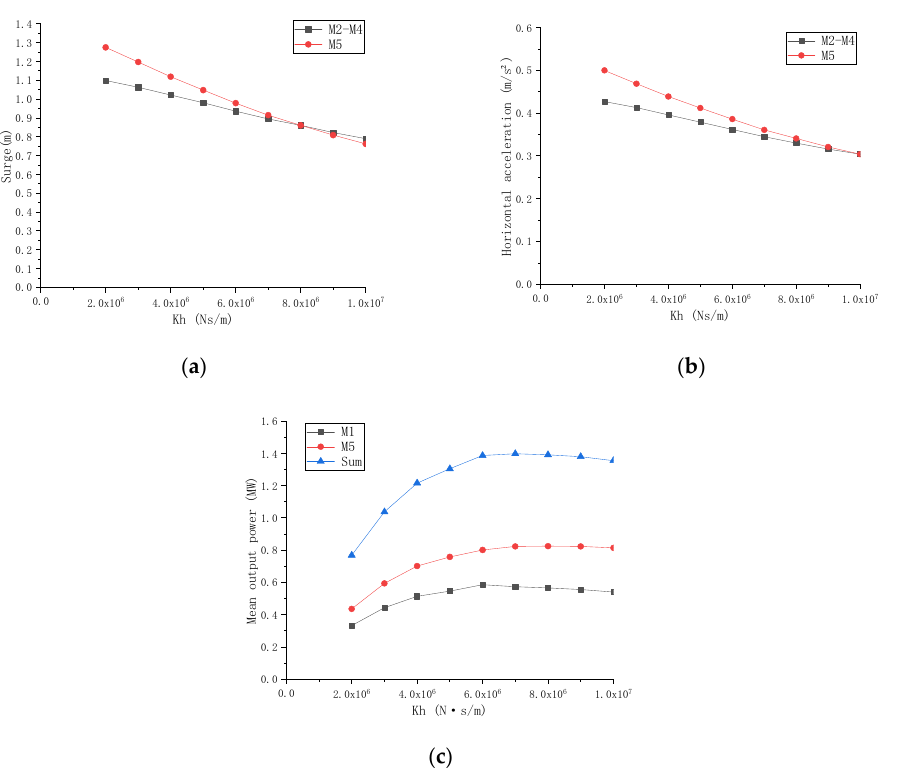
respectively. However, the peak of total horizontal WEC power appears at the K h of 7.0 ×